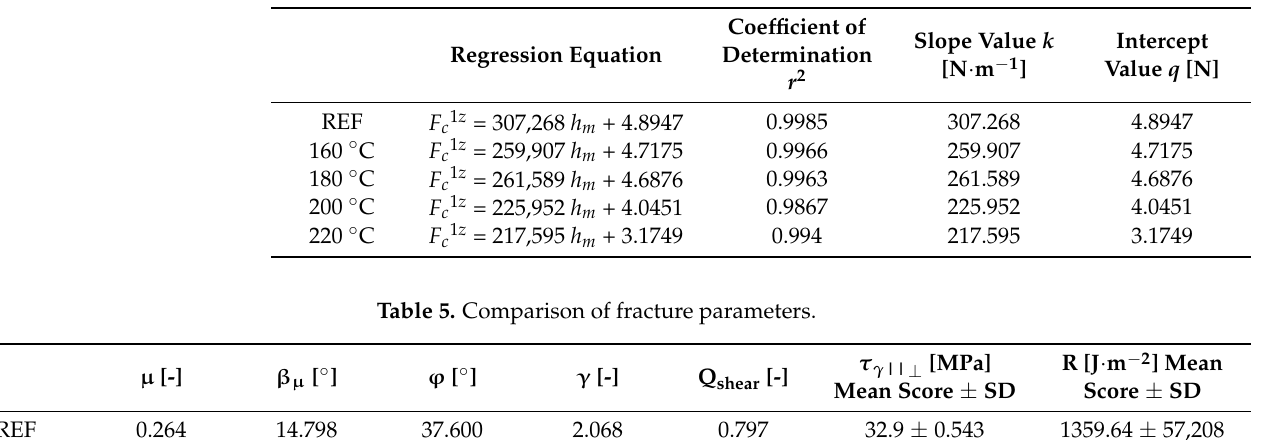
Table 4. Comparison of regression equation, coefficient of determination values, slope values, and intercept values.